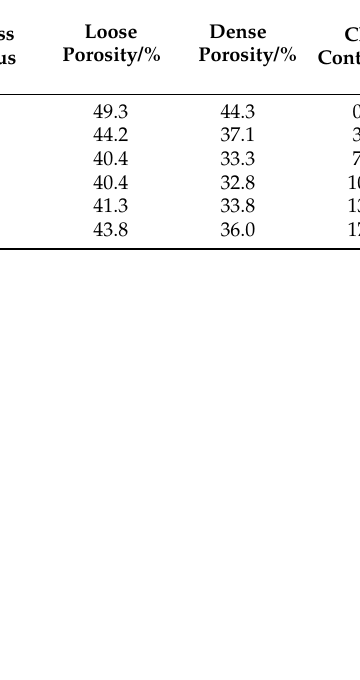
Table 3. Particle gradation, fineness modulus, porosity, and clay content of each mixed sand. SSTS Replacement Nos. Rates/%